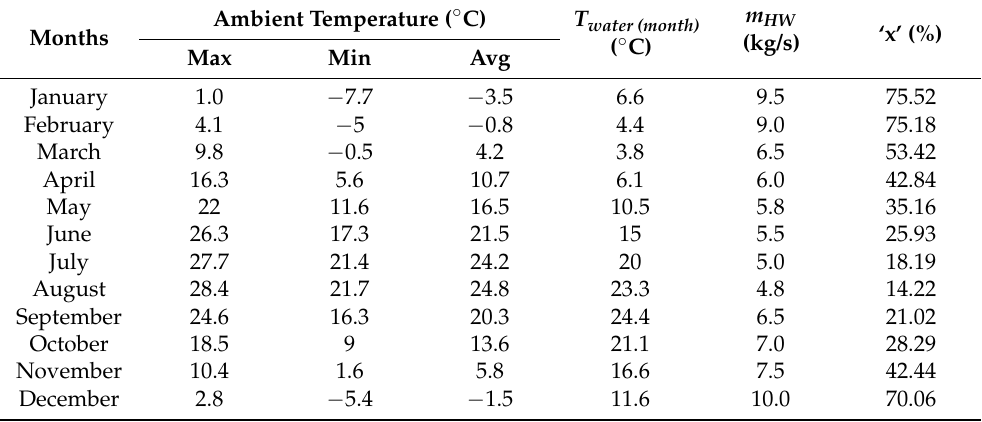
Table 1. Monthly input parameters for Seoul, South